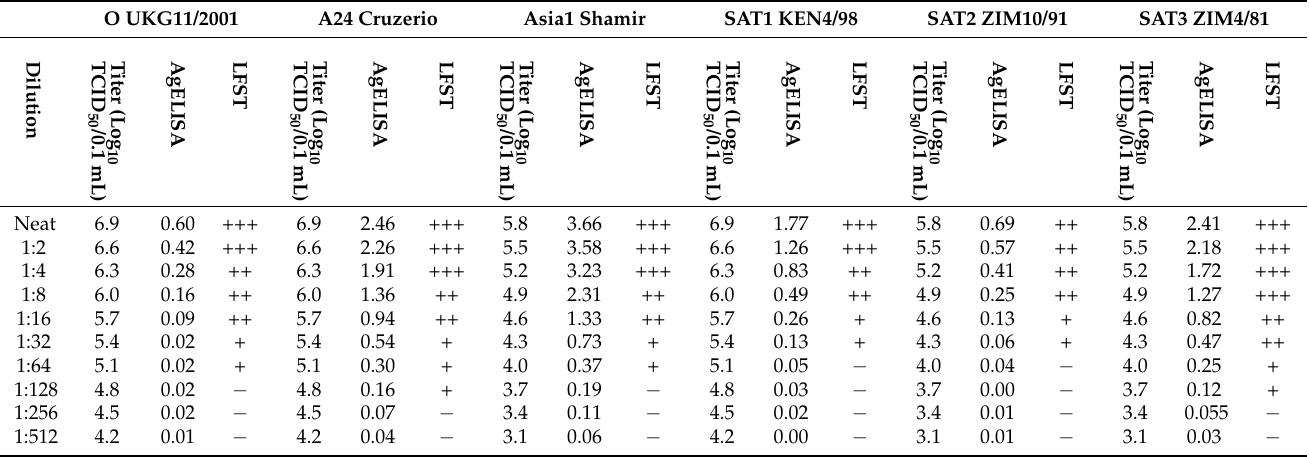
Table 1. Comparison of analytical sensitivities of antigen detection ELISA (AgELISA) and pan-sero-